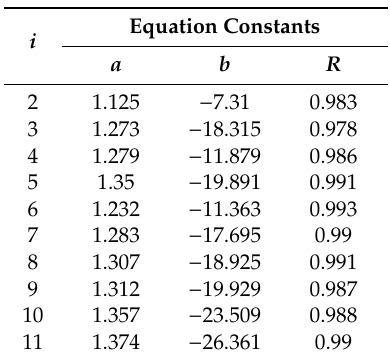
Table 1. The constants of the linear relationships between the normalized reflectance spectra R 1 ( λ ) and each R i ( λ